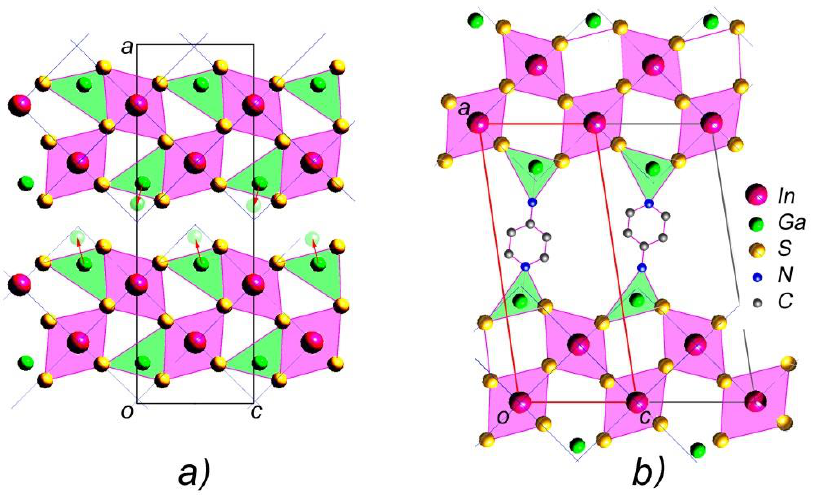
Figure 5. ( a ) The projection of the In 1.2 Ga 0.8 S 3 crystals and ( b ) the model structure of intercalated In 1.2 Ga 0.8 S 3